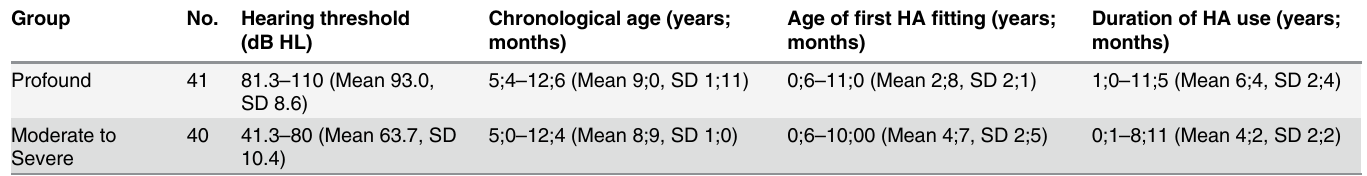
Table 1. Demographics of children participated in the current study. Range of data is listed in the top row and mean and SD are listed in the bottom row for each subject group. Group